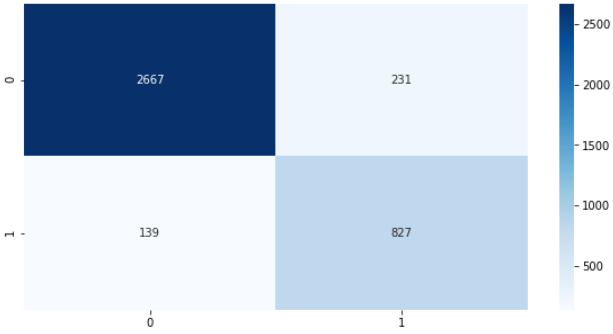
Figure 7. The highest results of the confusion matrix of 7 electrodes with DA.